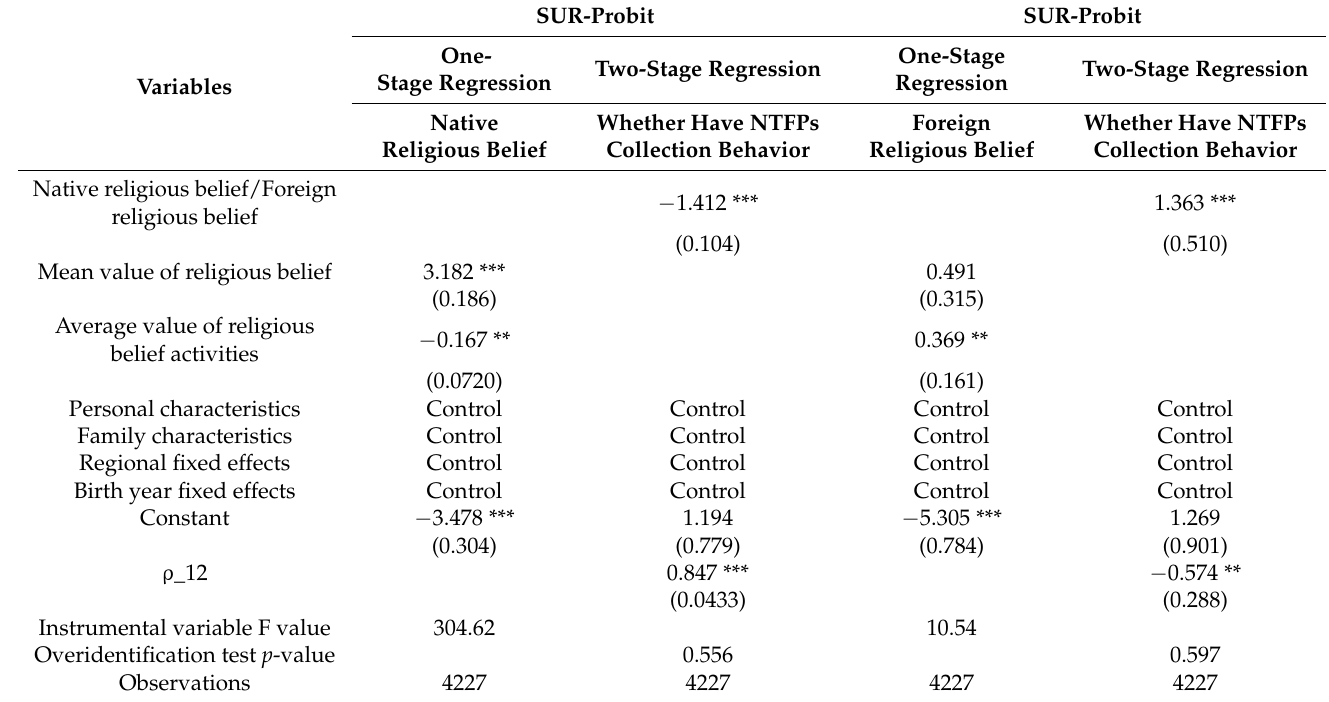
Table 9. Baseline regression for native and foreign religious beliefs and NTFPs collection behavior.